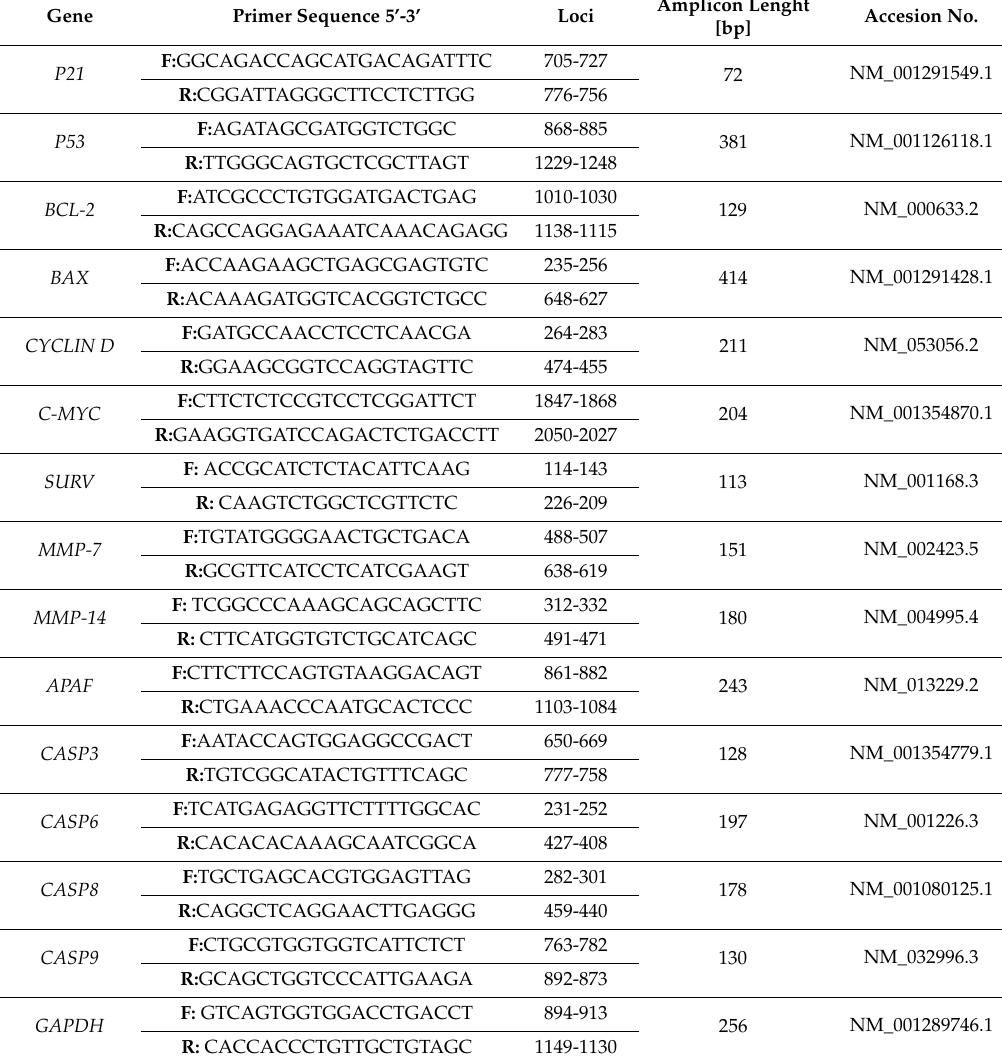
Table 1. List of primers used in quantitative reverse transcriptase real-time polymerase chain reaction (RT-qPCR) for